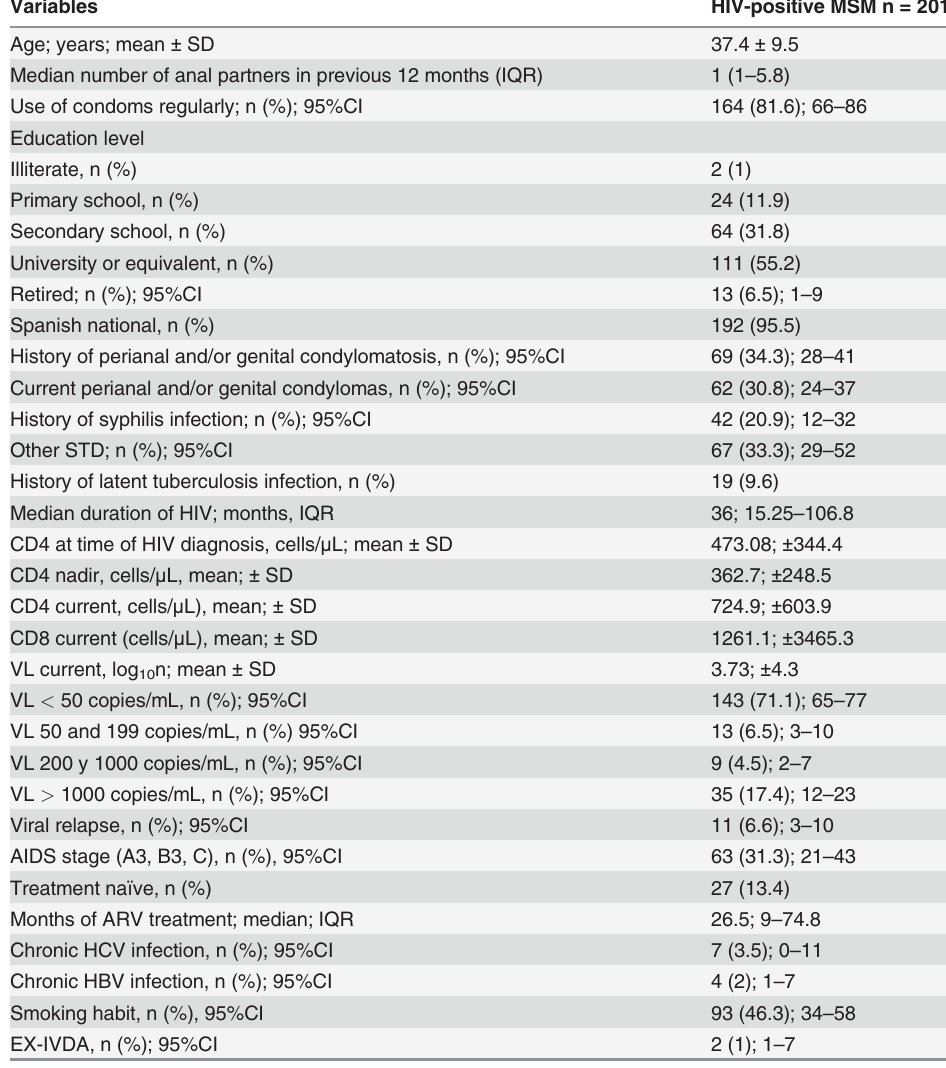
Table 1. General description of the patient study